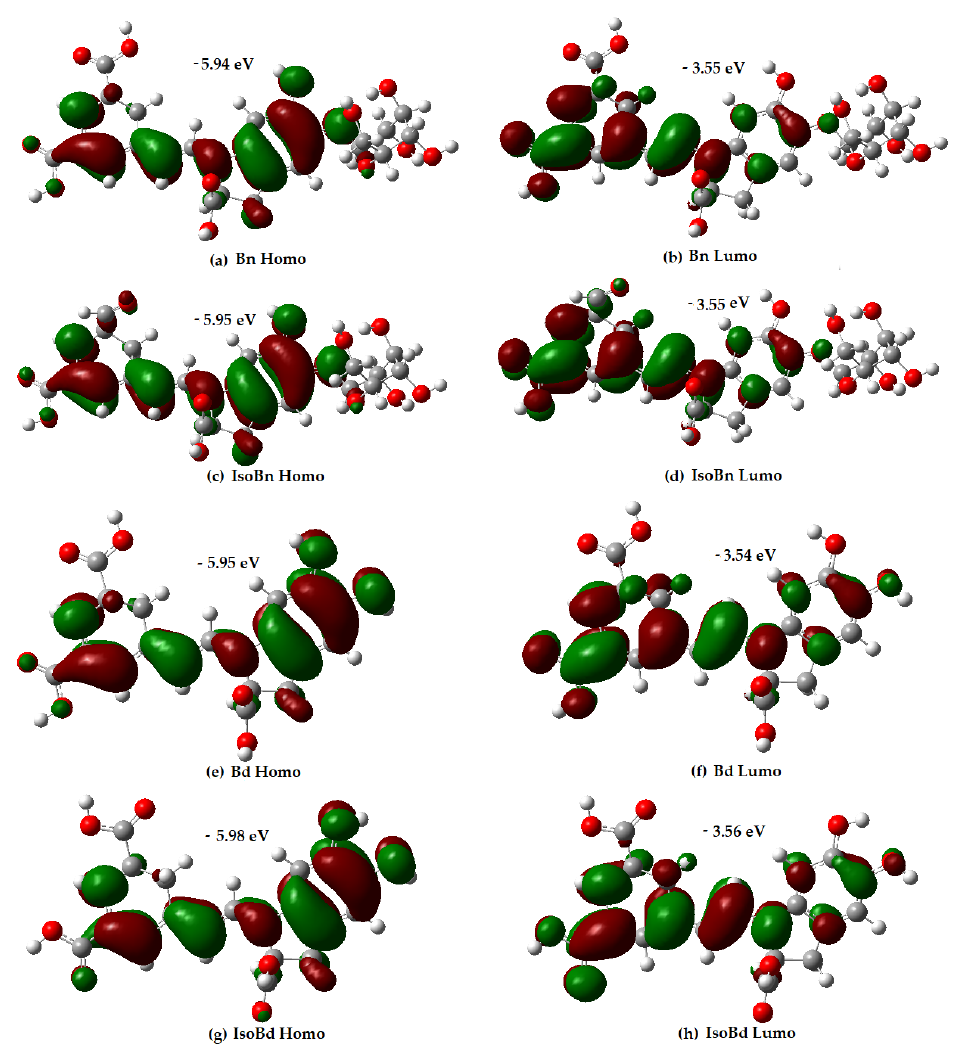
Figure 1. Energy and distribution of HOMO and LUMO for Bn, IsoBn, Bd, IsoBd. The compounds’ IP descriptor in kcal/mol increases as follows: Bn < IsoBn < IsoBd <